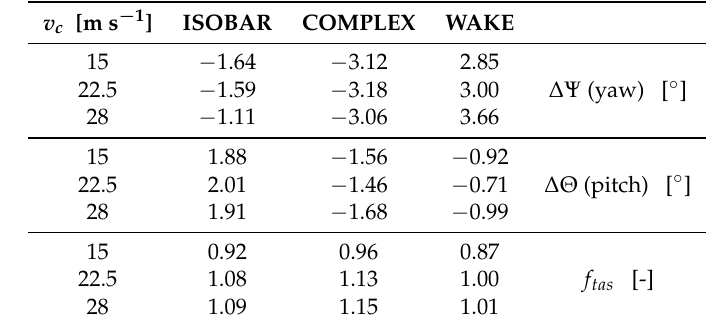
Table 1. Correction offsets ∆Ψ (yaw angle), ∆Θ (pitch angle) and correction factor f tas (multiplied with the norm of the true airspeed | (cid:126) u a | ). Three sets of correction factors for the flight experiments, and for the three calibration speeds at v c 1 , v c 2 and v c 3 are